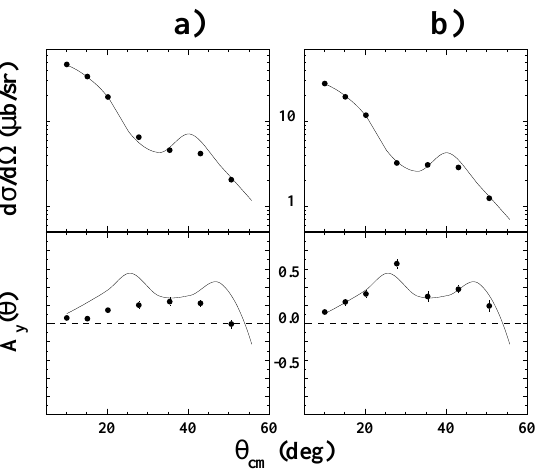
Fig. 5. Angular distributions of cross sections and asymmetries for the 118 Sn 4.045 MeV 3 − (a) and 4.121 MeV 2 − (b) daughter states homologous to the 0.315 MeV 1 / 2 − 117 In parent state. Dots refer to the experimental values of the daughter states and solid lines to the experimental values of the parent